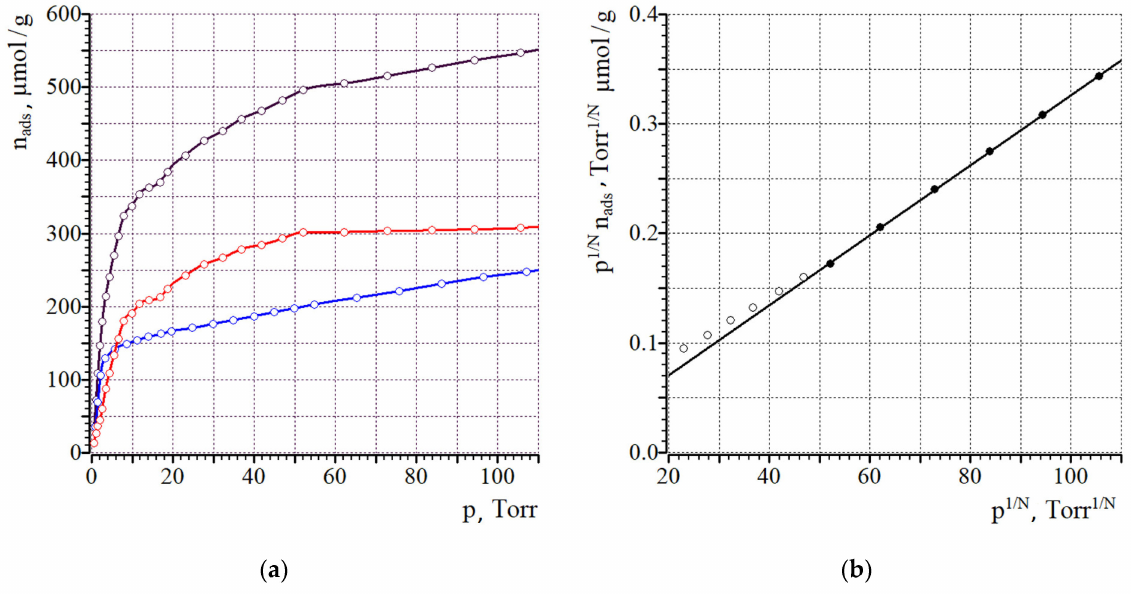
Figure 7. Isotherms of CO sorption (1st run—black, 2nd run—red, difference isotherm—blue) for Ni/C-3 ( a ) and the fit in the model of Langmuir adsorption, where N is the dissociation stoichiometry coefficient, N = 1 for this case ( b ). On ( b ), filled symbols indicate those, which were used for linear fit.